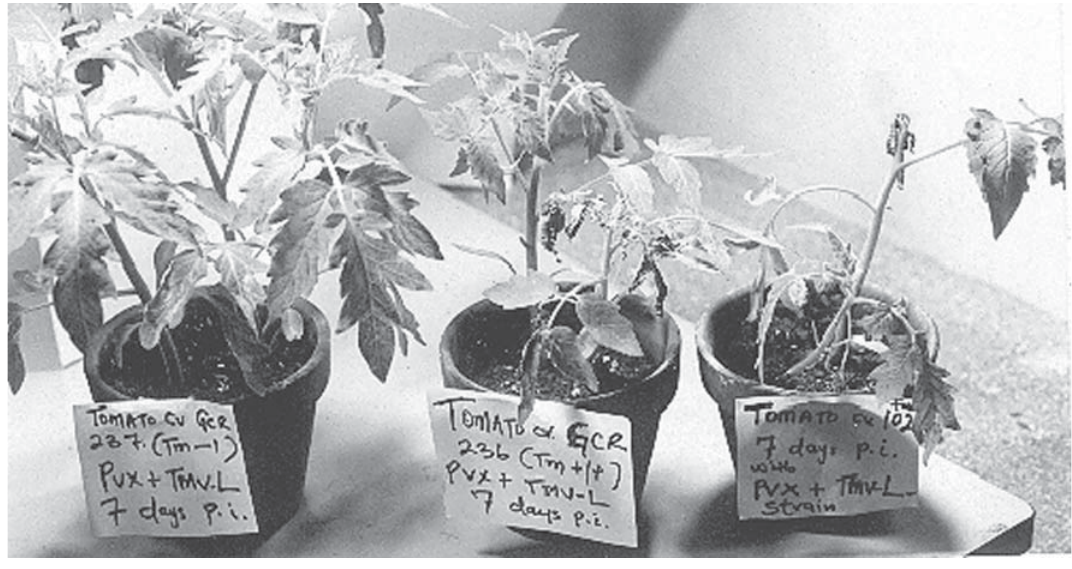
Fig. 1. Foliar symptoms in three cultivars of tomato after mixed infection with PVX and ToMV-L, 7 days after inoculation. A, GCR 237 (Tm-1); B, GCR 236 (+/+); C, Fukuju No.